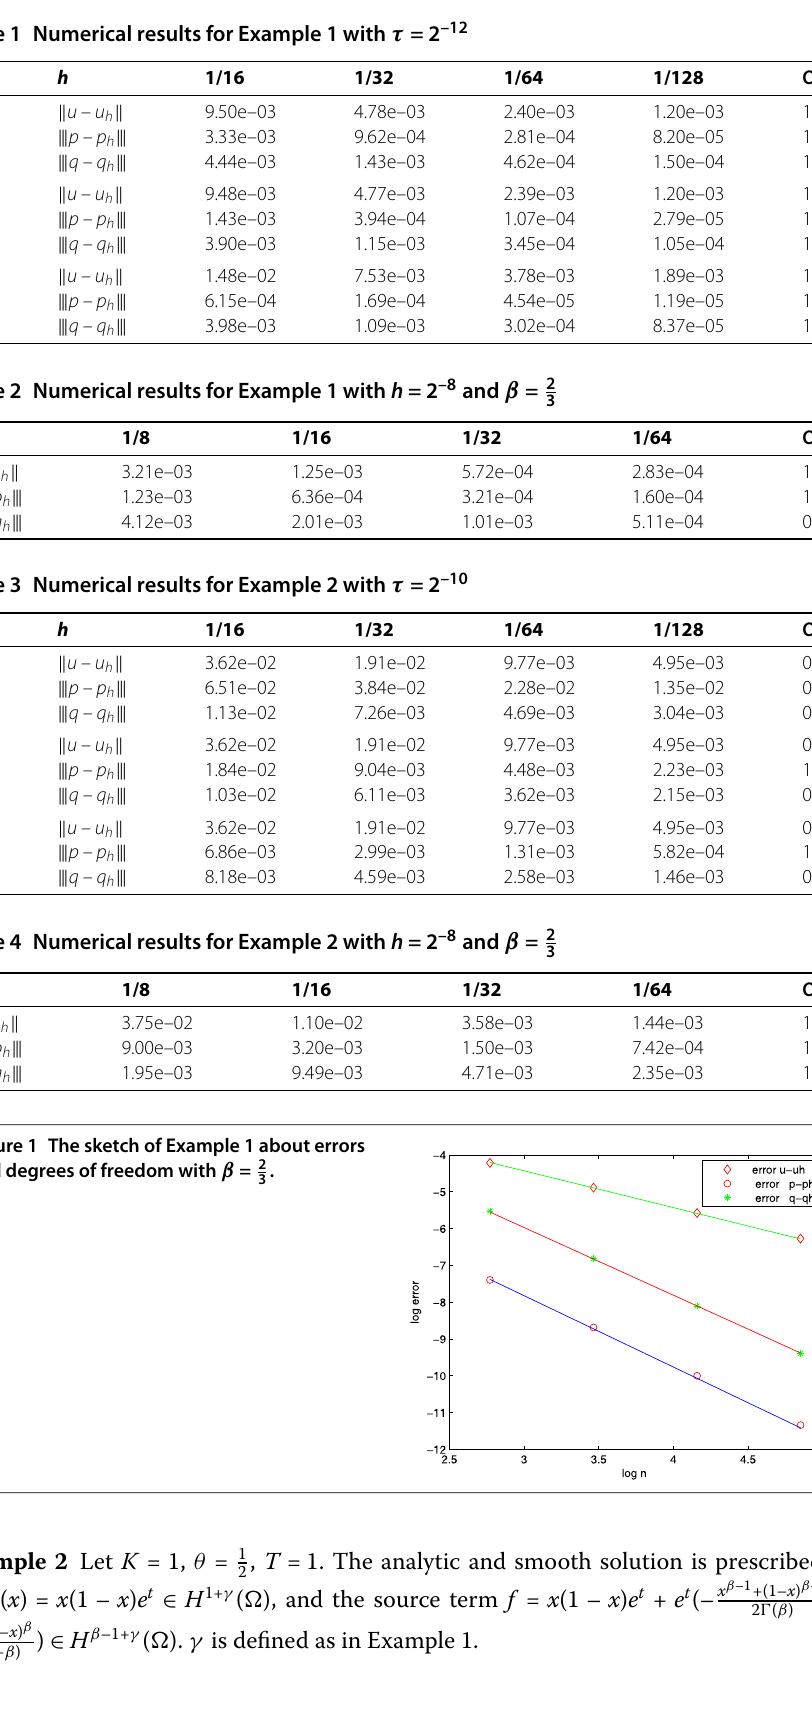
Table 1 Numerical results for Example 1 with τ = 2 –12